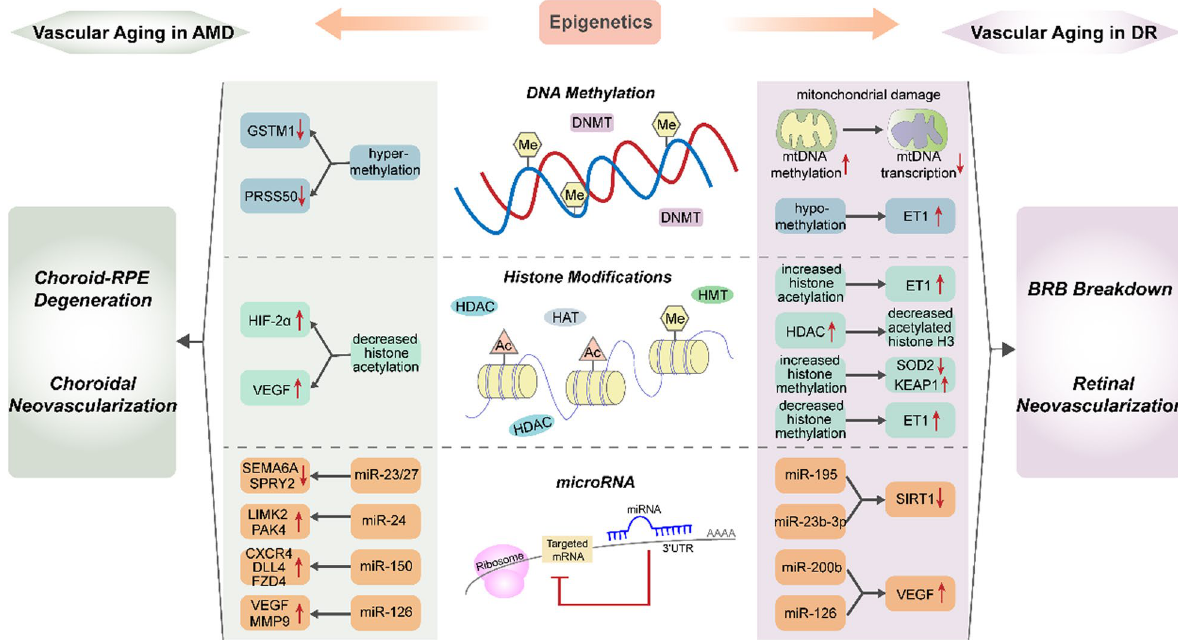
Fig. 3 Diagram of the epigenetic regulation of vascular aging in DR and AMD. The dysregulation of DNA methylation, histone modifications and microRNA in microvessels induces alterations in the expression of targeted genes, which are responsible for vascular aging in the process of DR and AMD. AMD: age-related macular degeneration, CXCR4: C-X-C chemokine receptor type 4, DLL4: Delta like ligand 4, DNMT: DNA methyltransferase, DR: diabetic retinopathy, ET1: endothelin-1, FZD4: frizzled-4, GSTM1: glutathione S-transferase isoform mu1, HAT: histone acetyltransferase,